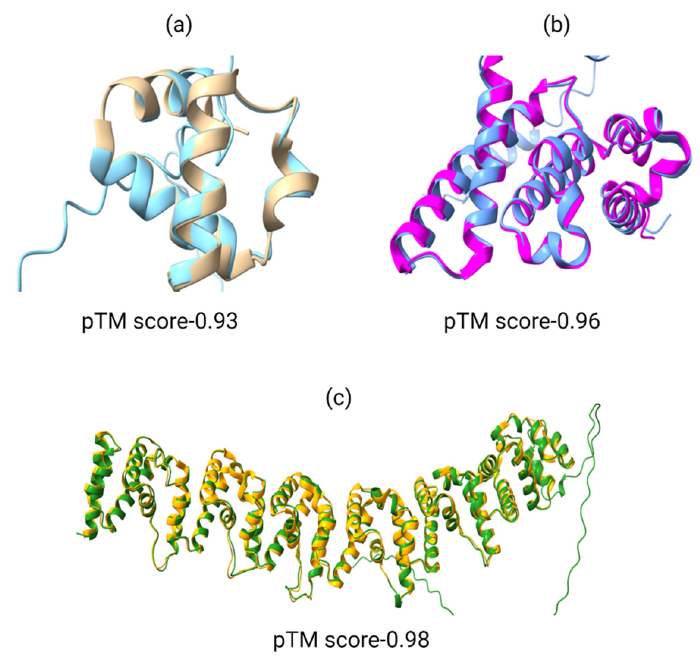
Figure 3. Comparison of crystal structures of avirulence proteins of P. sojae with AlphaFold pre- dicted structures by superposition. As expected, the crystal and predicted structures were highly similar except at the disordered regions. ( a ) PsAvr1d comparison: golden color represents PsAvr1d crystal structure while cyan blue represents AlphaFold predicted structure of PsAvr1d. ( b ) PsAvh240 comparison: pink color represents the PsAvh240 crystal structure whereas blue repre- sents the AlphaFold predicted PsAvh240 structure. ( c ) PsPSR2 comparison: yellow color represents the crystal structure whereas green represents the AlphaFold predicted structure of PsPSR2. pTM is template score on a scale from 0 to 1. 6. Functional Characterization of Effectors in P. sojae Using CRISPR Homologous recombination based targeted gene knockout has been widely used for functional characterization of different genes in a number of plant pathogens [85]. This approach was very successful in many model pathogens such as Ustilago maydis but did not work efficiently in oomycetes and other fungal pathogens with an active non homol- ogous end joining (NHEJ) based DNA repair mechanism. Van West et al. (1999) success- fully silenced inf1 in P. infestans through internuclear gene silencing. Silencing Avr4/6 us- ing RNAi resulted in a gain of virulence of P. sojae isolates against Rps4 or Rps6 [86,87]. Qutob et al. (2013) silenced Avr3a in P. sojae by transgenerational gene silencing [88]. How- ever, gene-silencing based on reverse genetics is still challenging in oomycetes and some fungal pathogens. CRISPR-Cas9 technology has been successfully applied in various pathogens and plant species [89]. Using this approach, one can precisely manipulate a given target gene in the genome of interest. Since its initial report, CRISPR technology has been used to generate knockouts or knock-ins in more than 40 fungal and oomycete pathogens [90], including P. sojae [8] and P. infestans [91]. Once the Cas9 generates a double-strand DNA break in the target region, DNA repair mechanisms are activated [92,93] and the break repaired either by a dominant non-homologous end-joining mechanism (NHEJ) or homol- ogy-directed repair (HDR). DNA repair by NHEJ introduces insertions or deletions, which leads to frameshift mutations resulting in gene knock out. In some fungal species, where homology-directed repair is active, a double-strand DNA break will be repaired using a repair template (donor DNA) containing a selectable marker flanked by target regions.